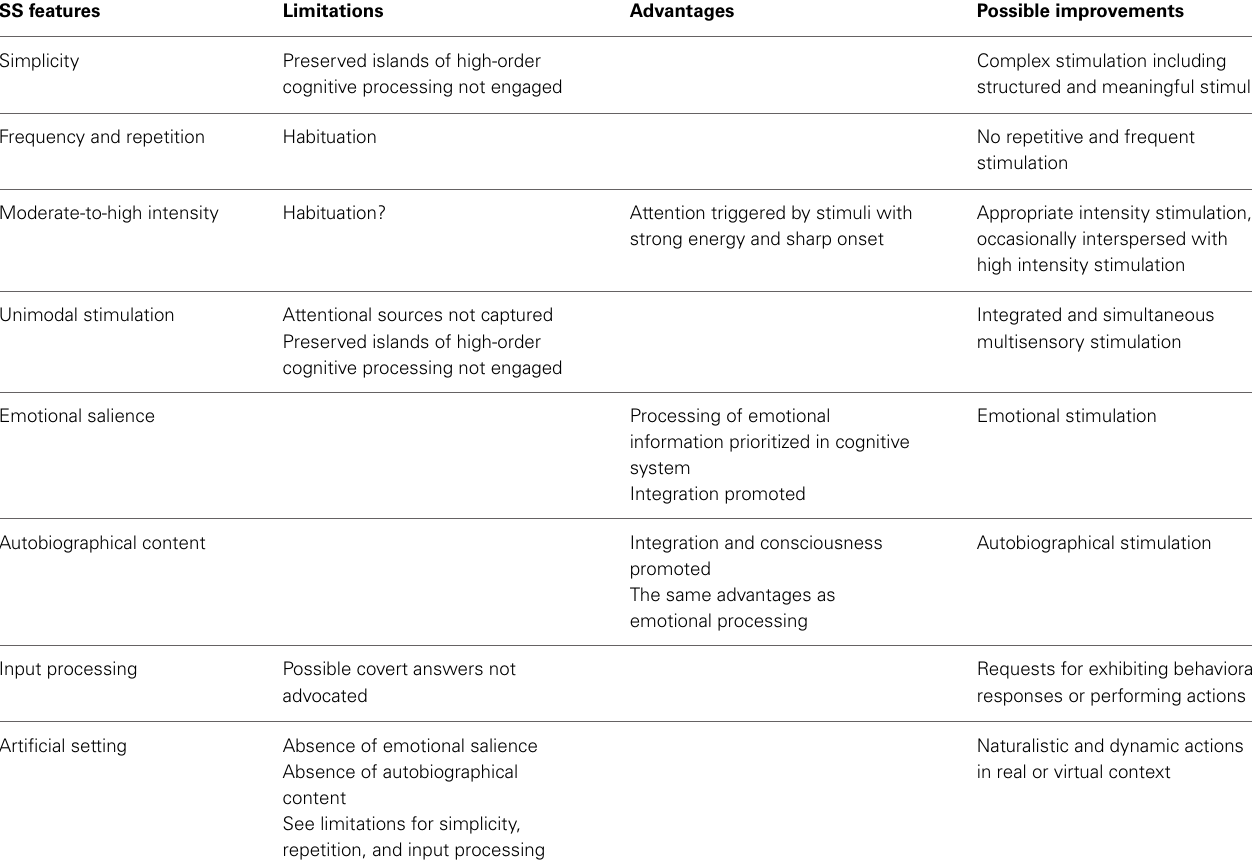
Table 1 | Revision of the main features of the SS standard method and suggestions for possible